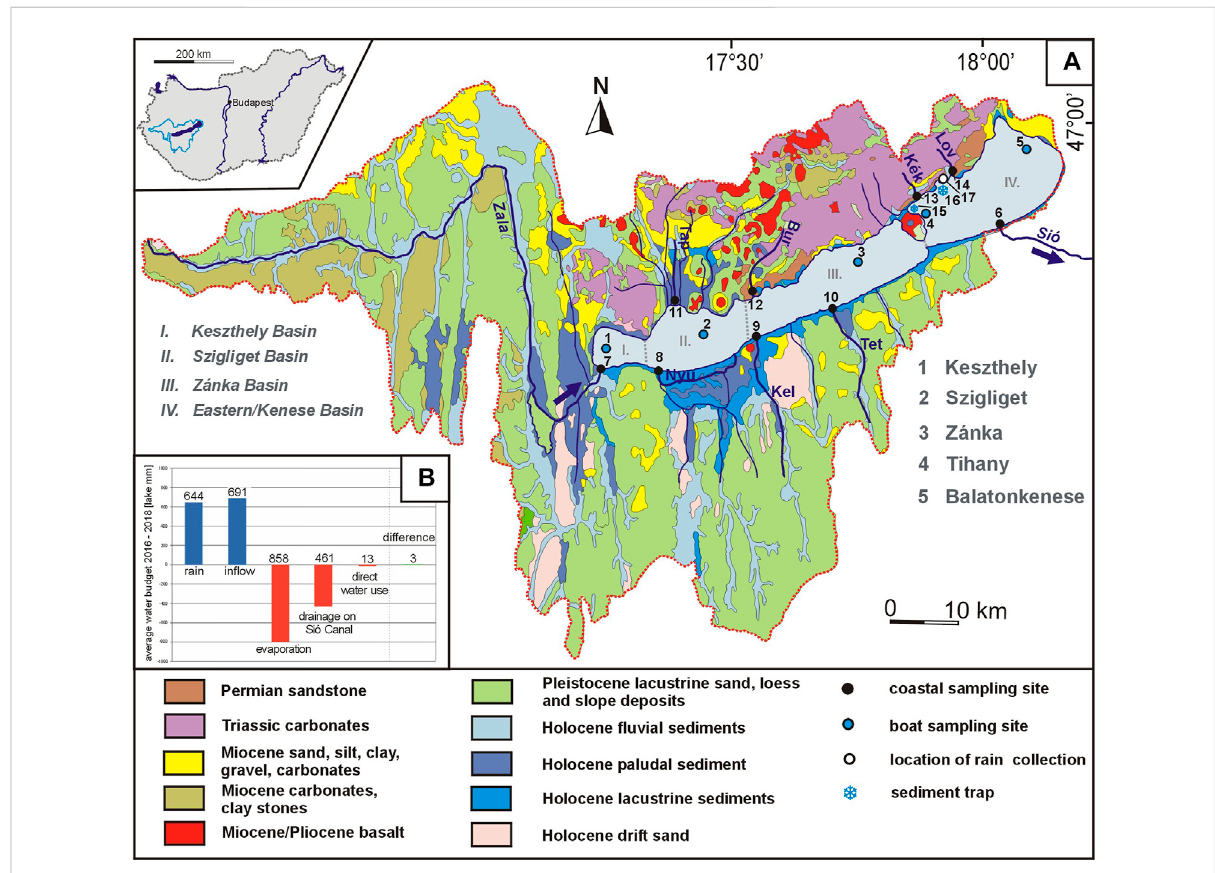
FIGURE 1 (A) Simpli fi ed geological map of the catchment area of Lake Balaton (after Budai et al., 1999) with sampling sites marked. The location of lake samples is shown by blue dots (1 Keszthely, 2 Szigliget, 3 Zánka, 4 Tihany, 5 Balatonkenese). Black dots indicate sampling sites at the only out fl ow (6 Sió Canal) and major in fl ows (7 Zala River, 8 Nyugati-övcsatorna/Nyu, 9 Keleti-bozót árok/Kel, 10 Tetves-patak/Tet, 11 Tapolca-patak/Tap, 12 Burnót-patak/Bur, 13 Kéki Séd/Kék, 14 Lovasi Séd/Los). The two snow fl akes show sites (15. Diós Bay, 16. Csopak) where sediment traps were used under ice. White dot marks the location of rainfall collection (17 Csopak). The fl ow directions of the main tributary (Zala River) and the only arti fi cial out fl ow (Sió Canal) are also indicated. (B) Average water budget of Lake Balaton (2016 – 2018; KDT, 2017; KDT, 2018; KDT,